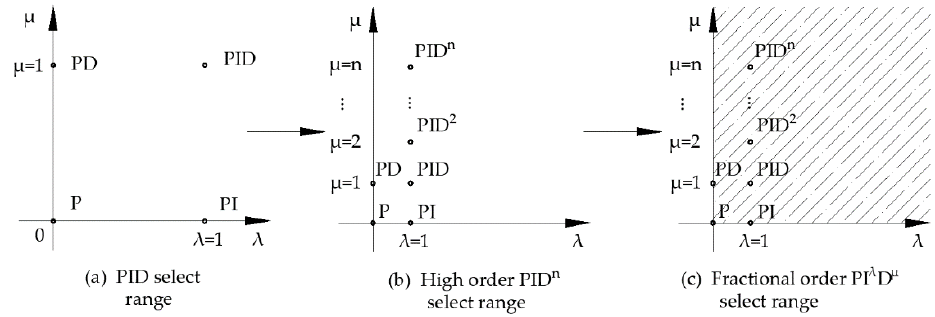
Figure 1. Selection range of different types of PID controllers.